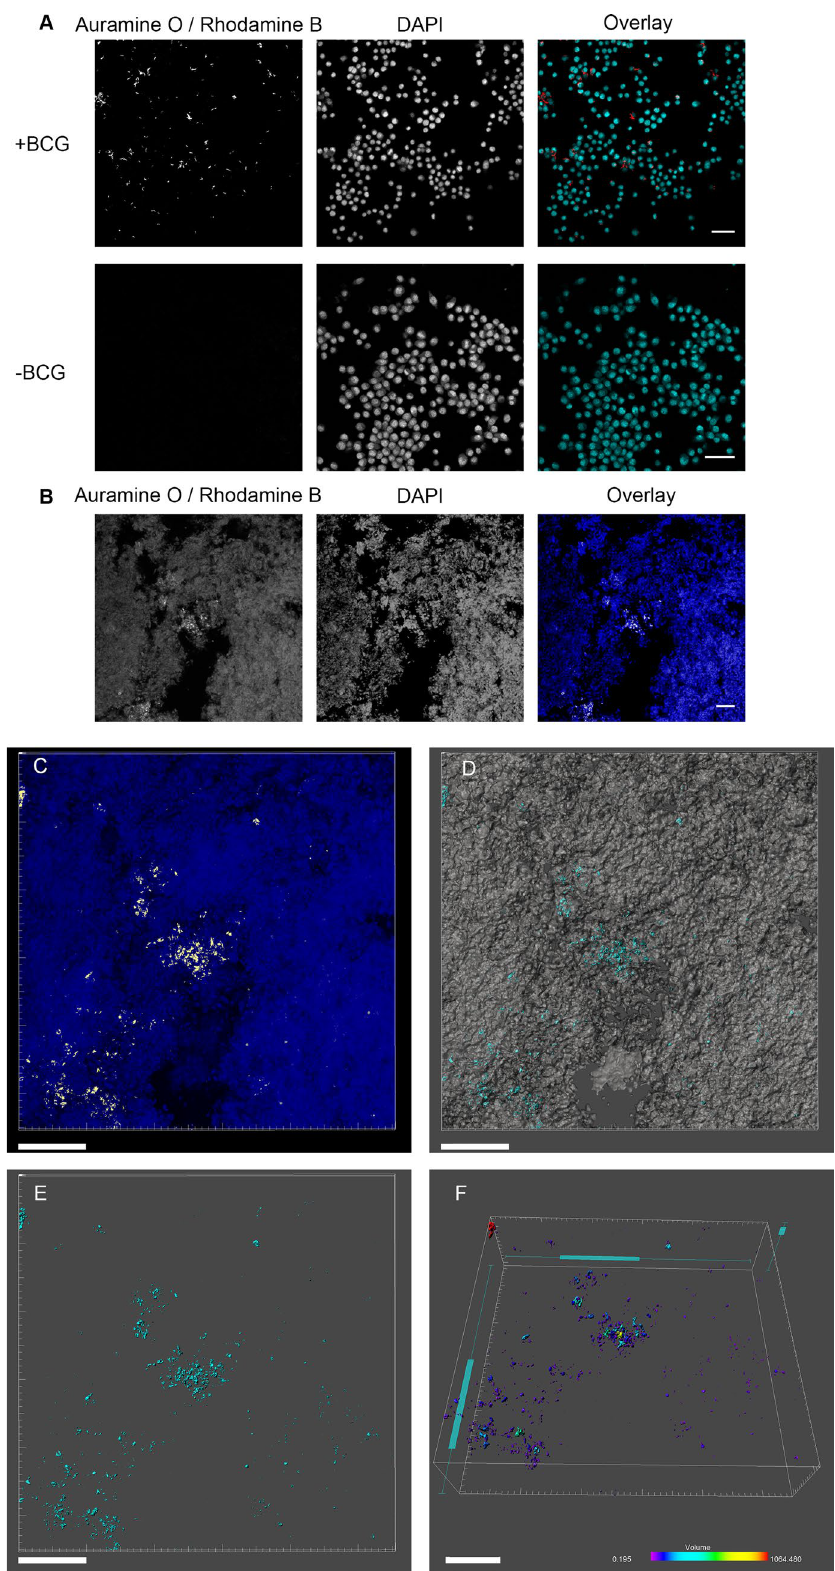
Figure 2. CUBIC Acid Fast (CAF) staining. CUBIC Acid Fast staining procedure demonstrated in ( A ) J774 macrophages infected with or without BCG, and ( B ) in a single CLSM optical section of Mtb infected tissue with a non-thresholded image presented. Multiple thresholded optical sections are then constructed into a Z stack (2 µm step size), with a maximum intensity projection presented ( C ) with the AurO/RhodB (yellow) and DAPI (blue) signals visible. ( D ) shows the isosurfaces generated from the AurO/ RhodB signal (turquoise) and the DAPI signal (grey), and ( E ) illustrates just the AurO/RhodB signal which the volumes of the bacterial aggregates can be measured, as demonstrated in ( F ) with colony volume colour coded (in µm 3 ). Scale bar = 50 µm ( A , B ) and 100 µm ( C–F